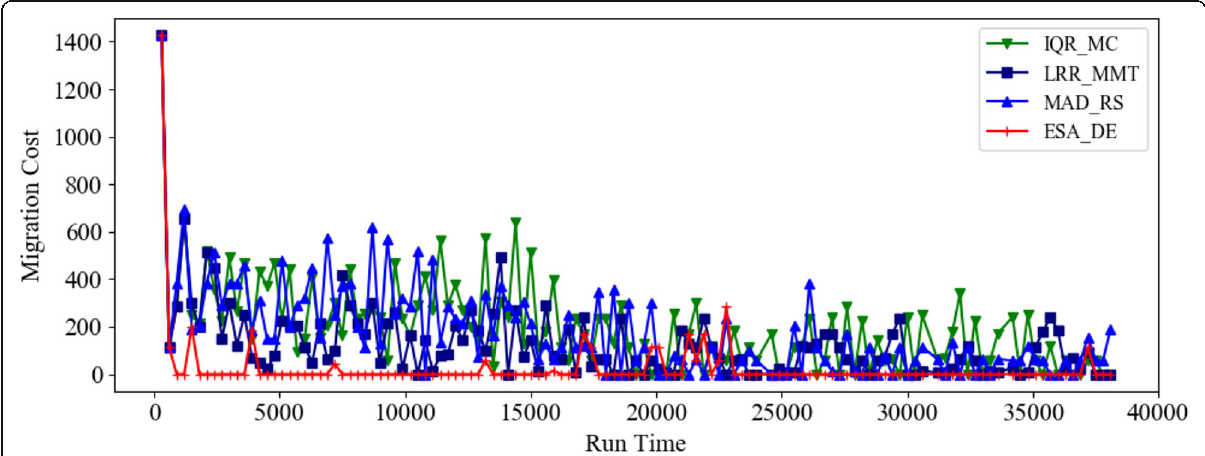
Fig. 7 Average migration cost of the virtual machine at different